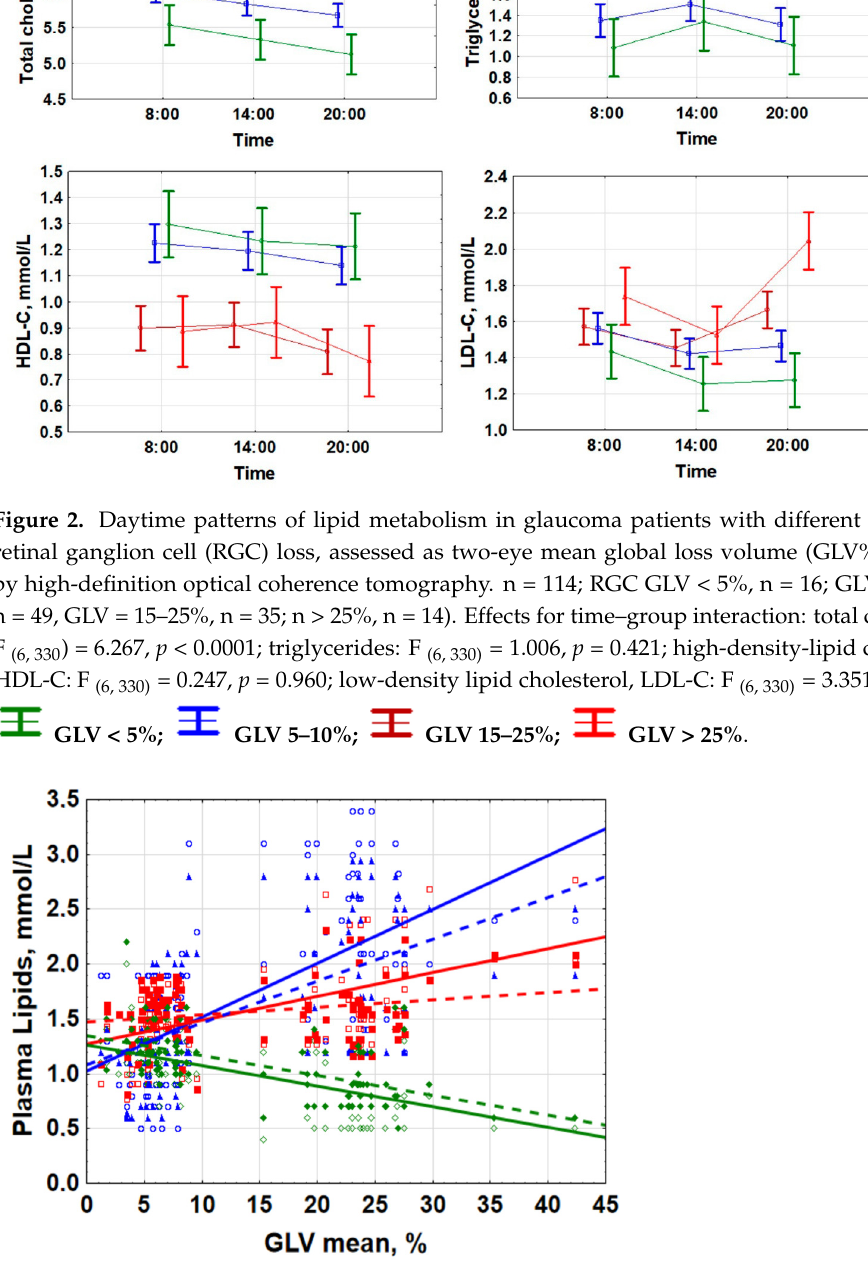
Figure 3. Changes in serum lipids associate with retinal ganglion cell (RGC) loss (two-eye mean global loss volume, %) in glaucoma. Evening (20:00) low-density lipid cholesterol (LDL-C) correlated more strongly with GLV% than morning (08:00) LDL-C; Dunn and Clark’s z = − 5.069, p < 0.0001. n =